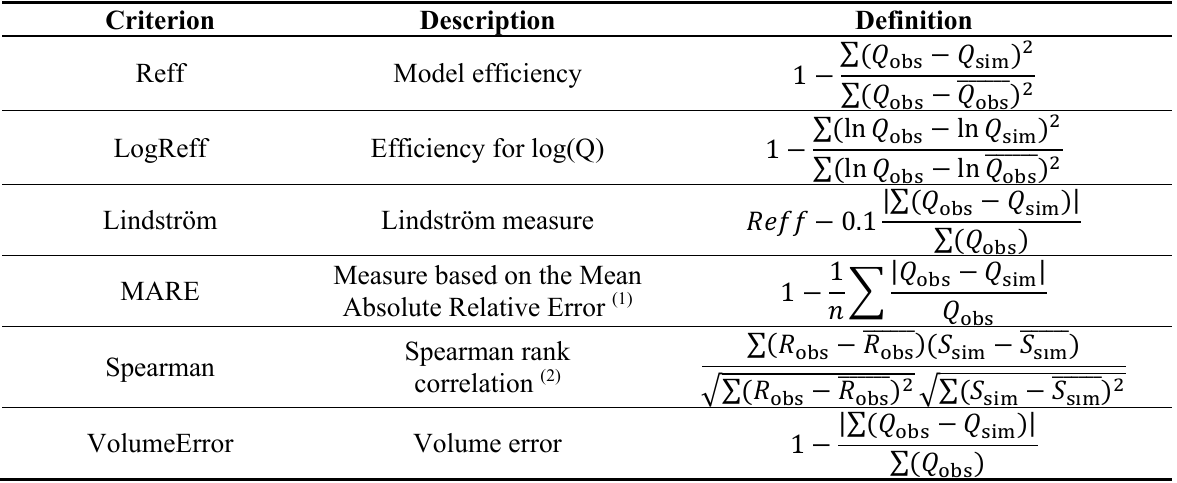
Table 3. Definitions criteria used in objective functions for the automatic calibration trials using the Genetic Algorithm and Powell optimization (GAP) algorithm.